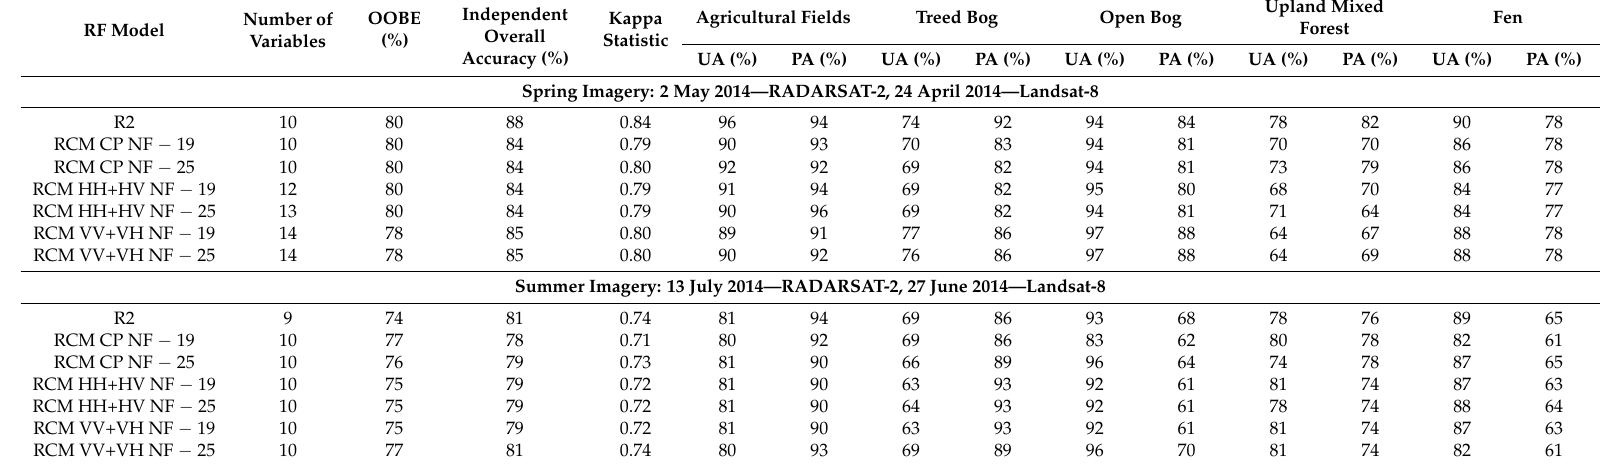
Table 4. Out of bag error (OOBE), Independent Overall Accuracy, Kappa Statistic, and per-class UA and PA or the spring and summer RADARSAT-2 and simulated RCM RF models with the highest Independent Overall Accuracy after variable reduction. All Random Forest models were a combination of either RADARSAT-2 or simulated RCM data, Landsat-8, and SRTM DEM